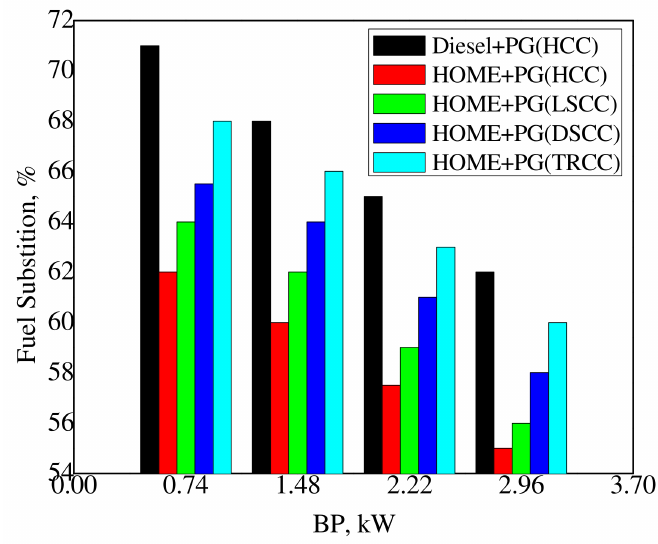
Figure 12. Effect of the combustion chamber type on fuel